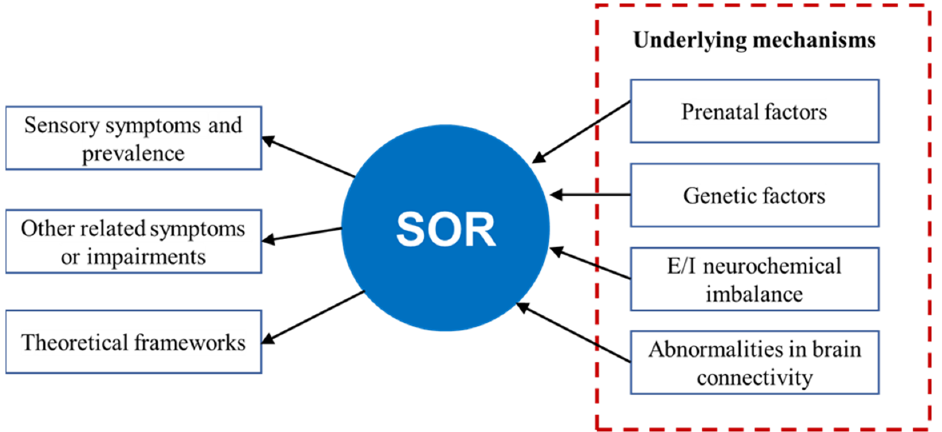
Figure 1. Summary of SOR, namely, symptoms, prevalence, co-occurrence symptoms, theoretical frameworks, and underlying